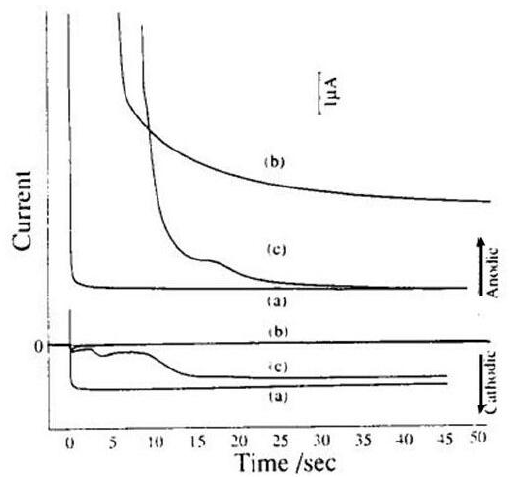
4.2. Electrochemical Stripping Voltammetry of Reversible Redox Species with Self Induced Redox